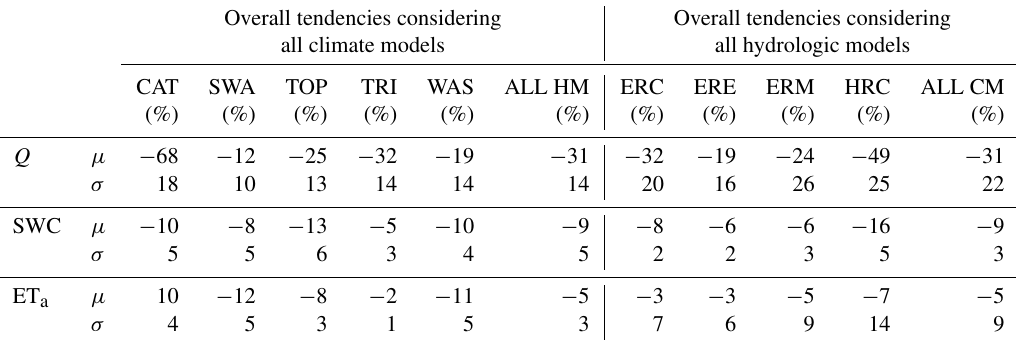
Overall tendencies considering